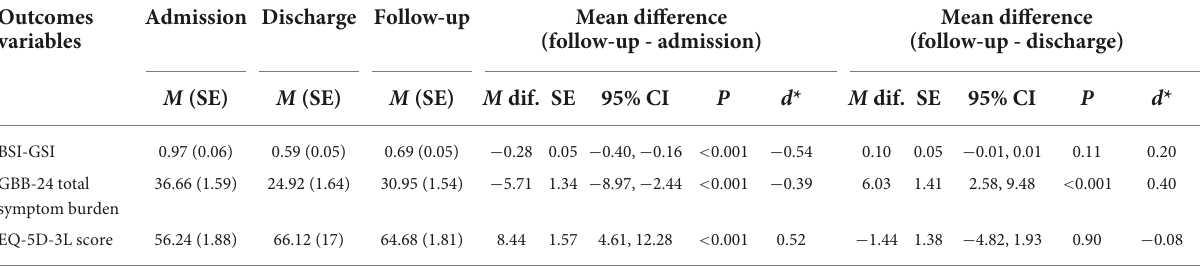
TABLE 3 Changes of psychological outcomes at follow-up compared to admission and discharge ( N = 92). Outcomes